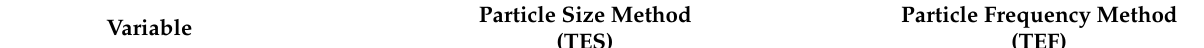
Table 1. Overview of factors that affect the determination of transport efficiency ( η n ) based on measured particle size/frequency and influences studied in this